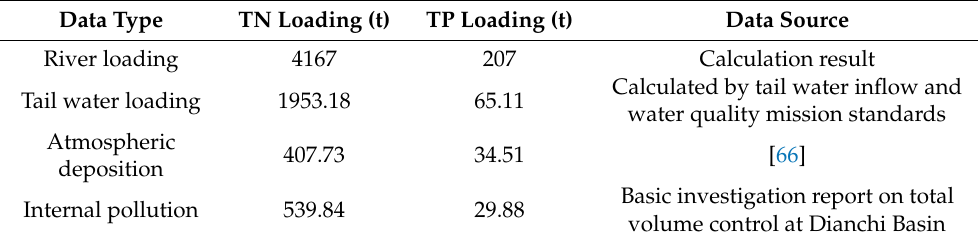
Table 6. TN and TP loadings from different sources at Waihai in